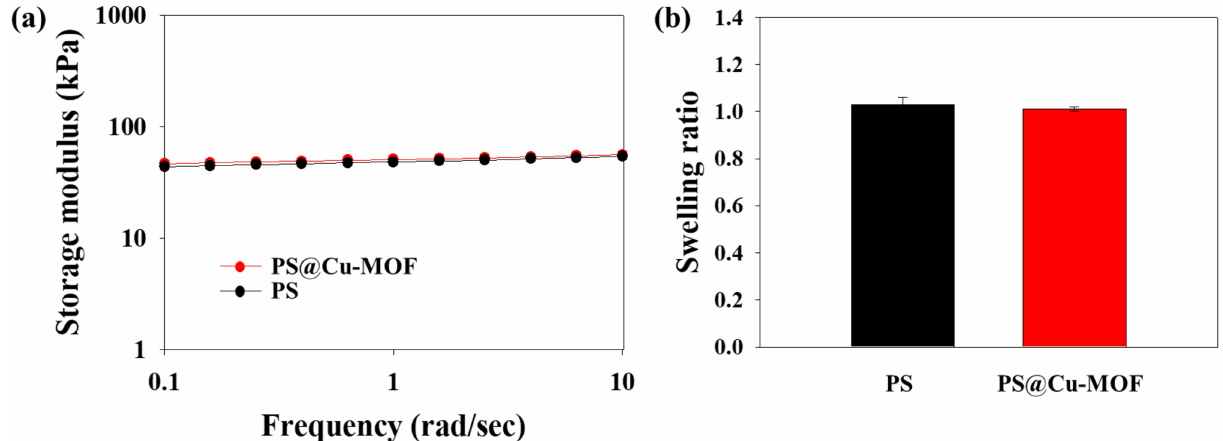
Figure 4. Physical properties of PS and PS@Cu-MOF. ( a ) Storage modulus and ( b ) swelling ratio of PS and PS@Cu-MOF (n =